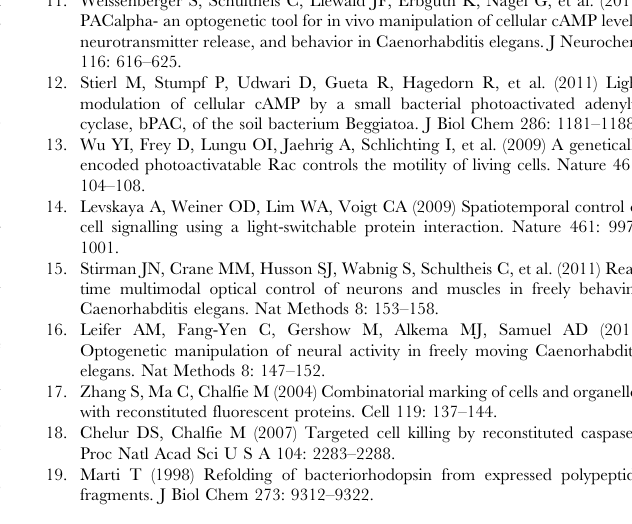
Figure S1 Fragment reconstitution of genetically split ChR2 and NpHR opsins in body wall muscle cells. ChR2 and NpHR were genetically split and resulting N- and C-terminal fragments were separately co-expressed in body wall muscle cells. Photoactivation with either blue (for ChR2 fragments) or yellow light (for NpHR fragments) was applied and resulting behavioral effects (contrac- tion or relaxation) were measured and compared to the effects evoked by the respective full-length opsin to test functional reconstitution. A, B ) Schematics of ChR2 (A) and NpHR (B), depicting heptahelical topology and sites of fragmentation, or YFP insertion, as indicated by colored arrowheads. Aminoacids flanking the fragmentation sites are given and